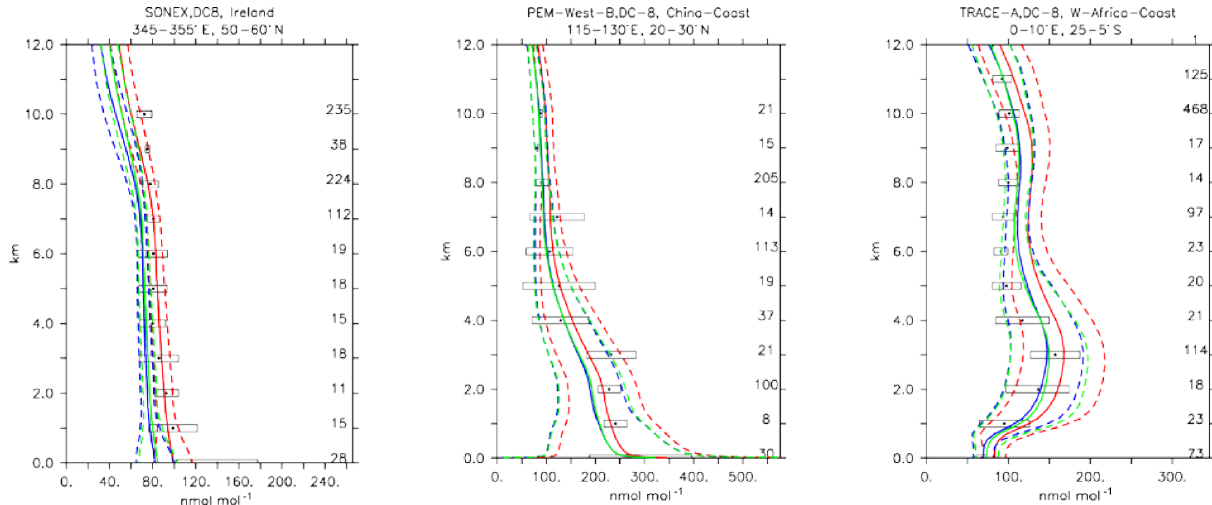
Figure 12. Comparison of simulated CO vertical profiles by using the CBA (red solid line), MOC (blue solid line) and MOZ (green solid line) chemistry versions against aircraft data (black dots). Also shown are the modelled (dashed lines) and measured (black rectangular) standard deviations. The numbers on the right vertical axis indicate the number of available measurements.